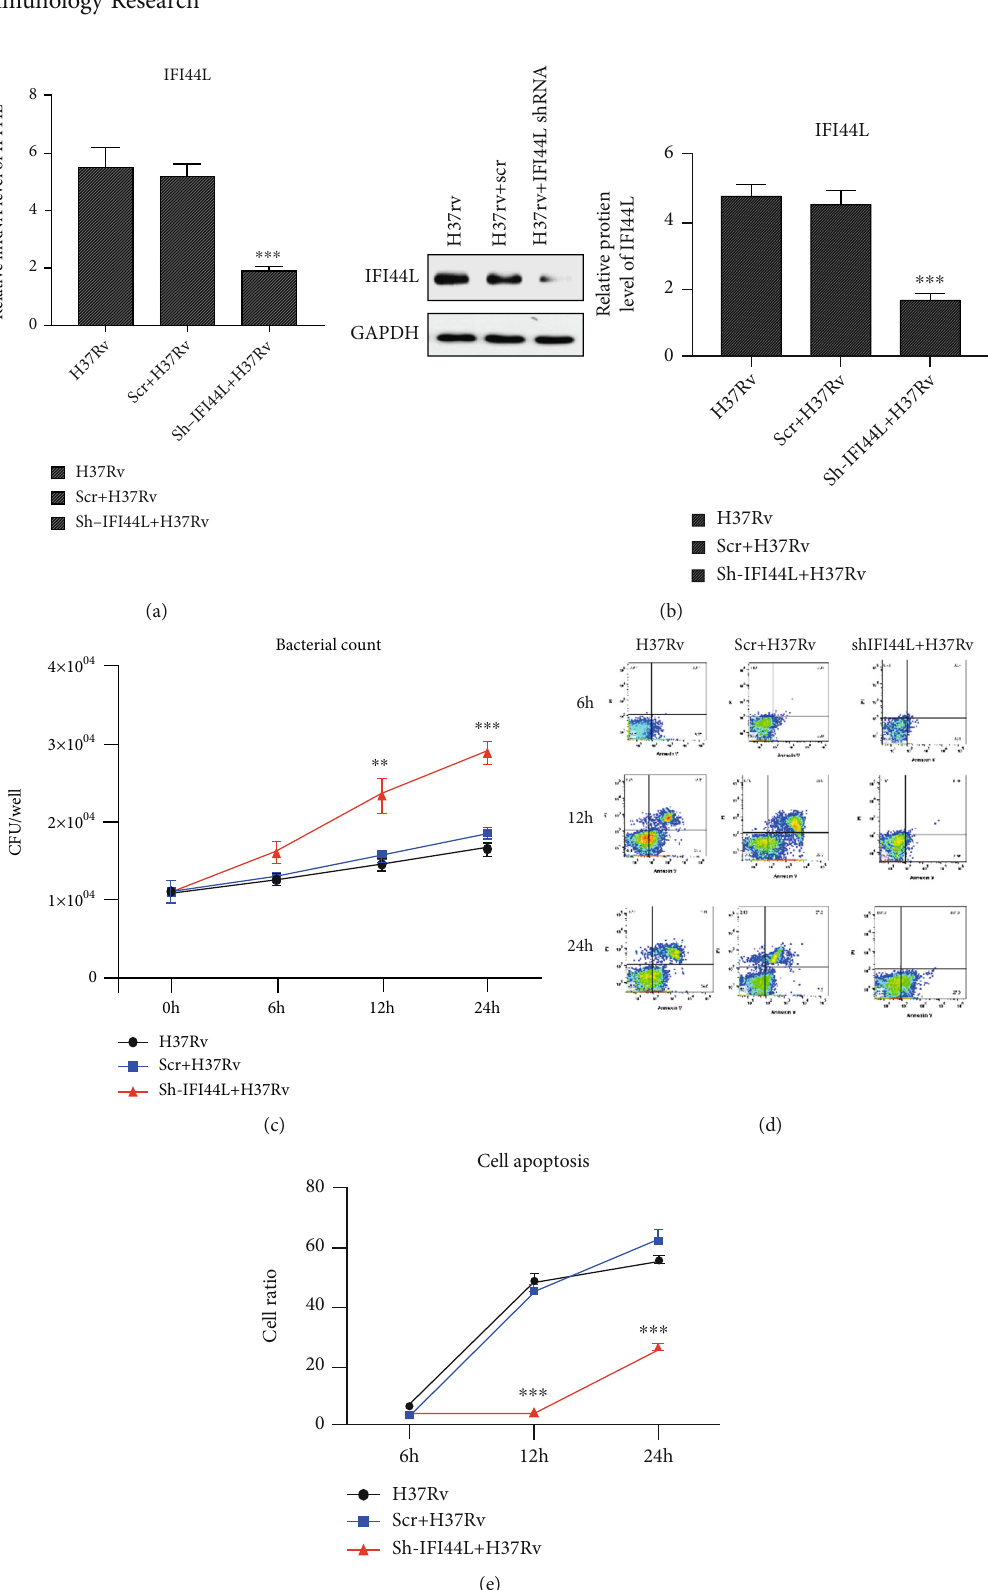
Figure 3: Relative levels of IFI44L and survival of M. tuberculosis H37Rv in the presence of shRNA-IFI44L. (a, b) THP-1 cells transfected with IFI44L-speci fi c shRNA (shRNA-IFI44L) and its scramble shRNA (Scr-shRNA) followed by M. tuberculosis H37Rv infection. (c) Survival of M. tuberculosis H37Rv augmented by CFUs in the presence of shRNA-IFI44L. (d, e) M. tuberculosis H37Rv-infected THP-1 cells with shRNA-IFI44L exhibiting signi fi cantly decreased cell apoptosis, as shown in fl ow cytometry. Values are presented as levels relative to β -actin. ∗∗ P < 0 : 01 ; ∗∗∗ P < 0 : 001